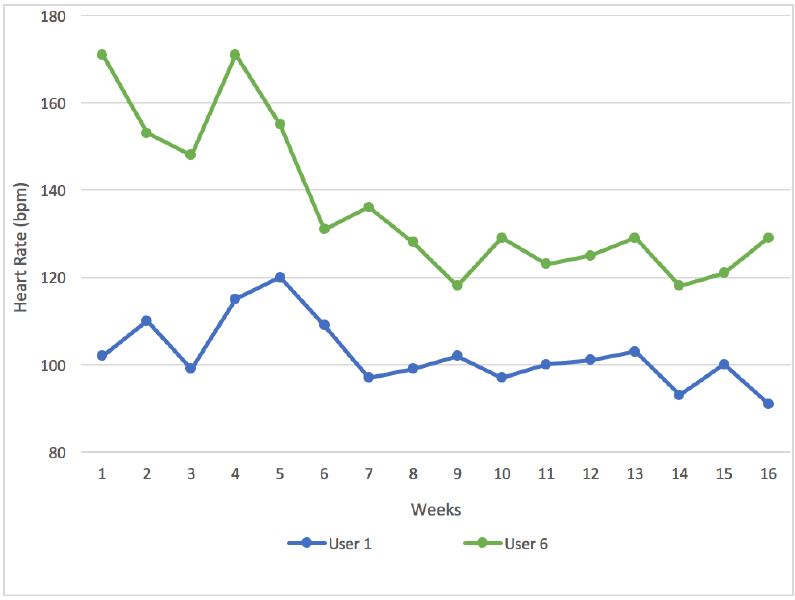
Figure 11. The evolution of the user’s heart rate during exercise, over the course of the case